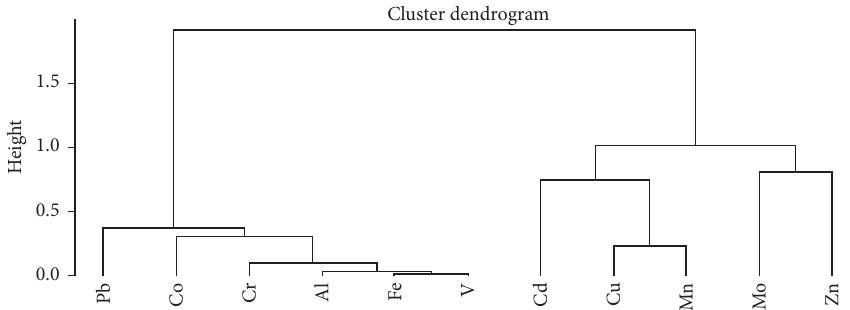
Figure 7: Dendrogram results of hierarchical cluster analysis for heavy metals.